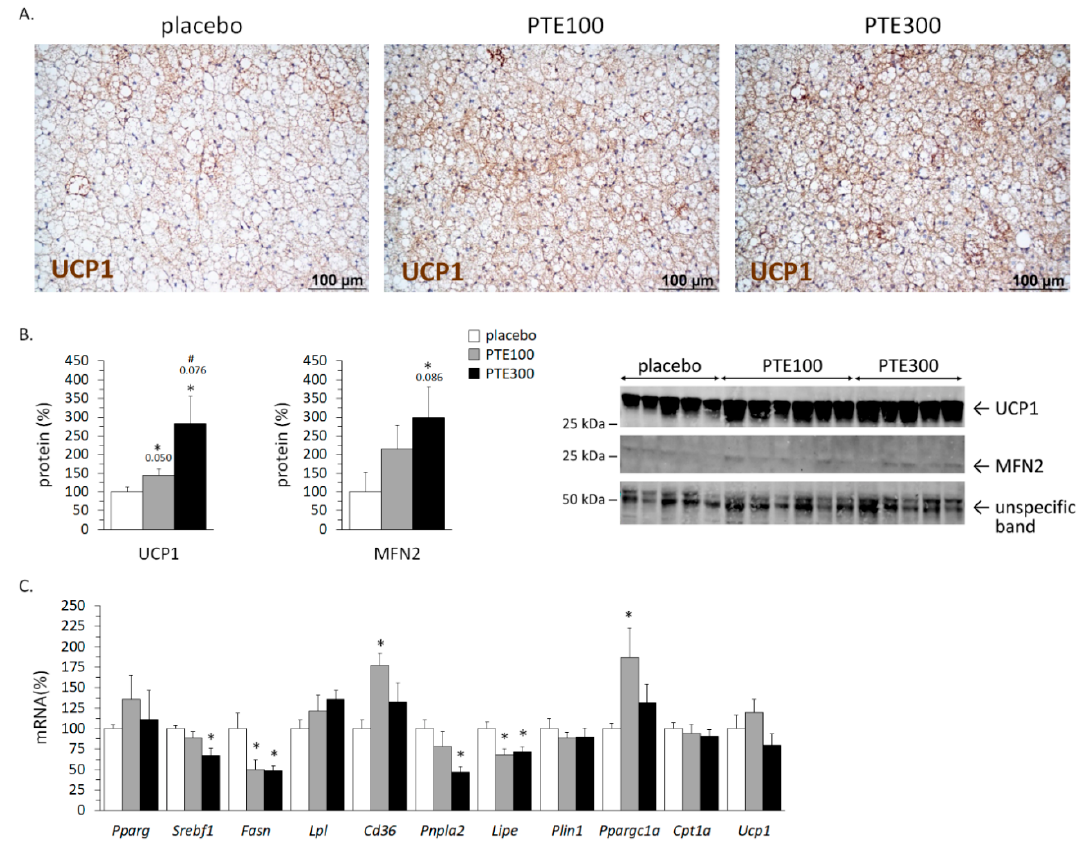
Figure 4. Phaeodactylum tricornutum ethanolic extract (PTE) activates interscapular brown adipose tissue (BAT) in C57BL / 6J mice fed with a high fat diet (HFD). Representative microphotographs illustrating BAT activation and Uncoupling protein (UCP) 1 immunostaining ( A ), UCP1 and Mitofusin (MFN)